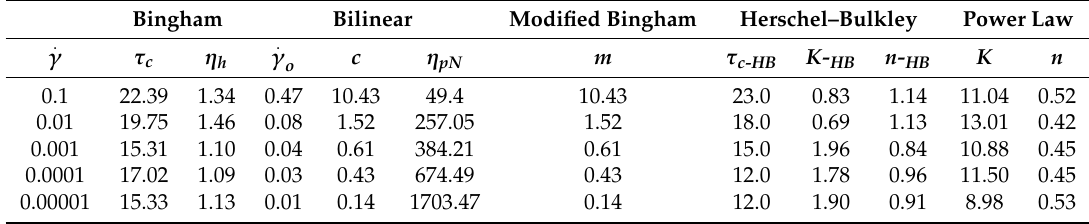
Table 1. Rheological properties obtained from different rheological models.